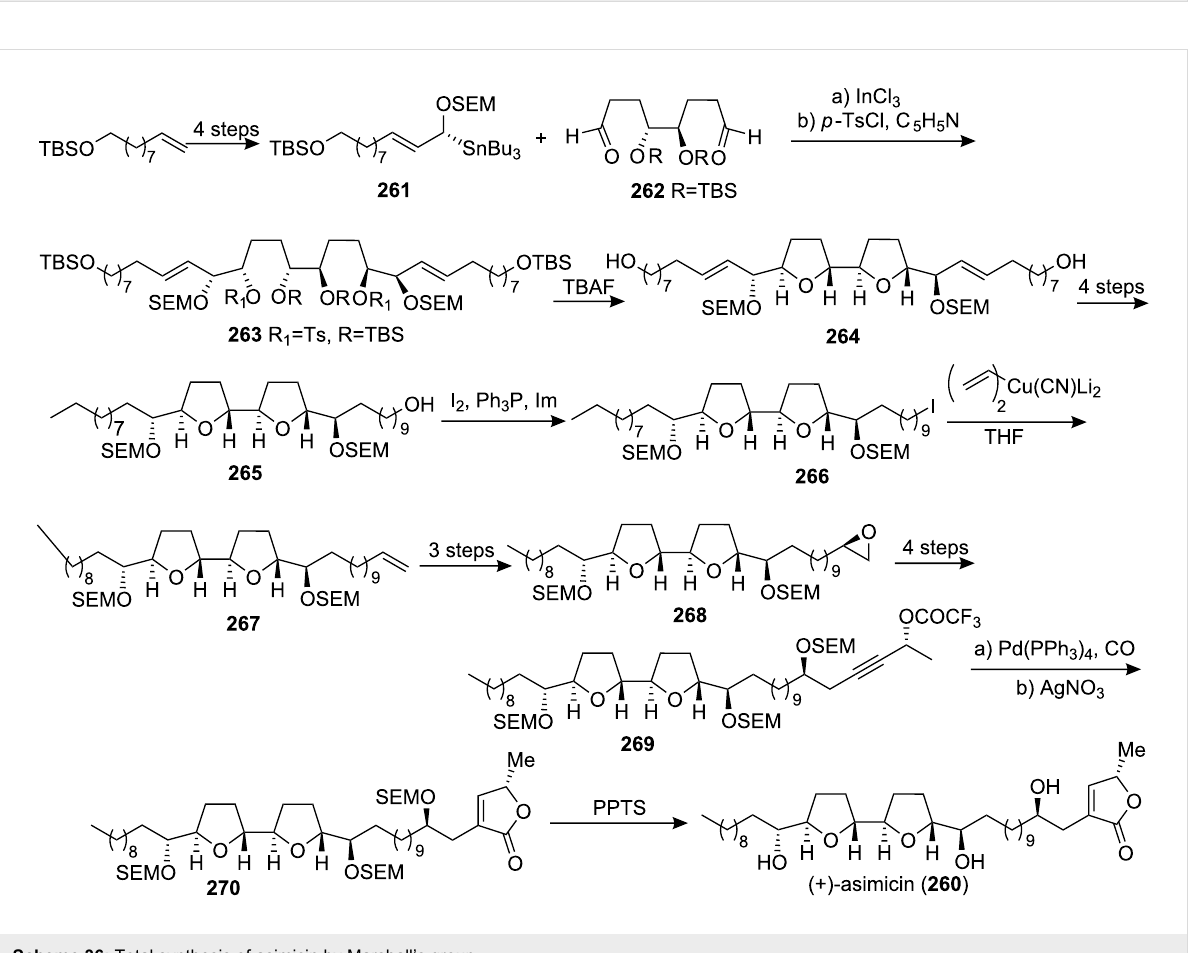
Scheme 36: Total synthesis of asimicin by Marshall’s